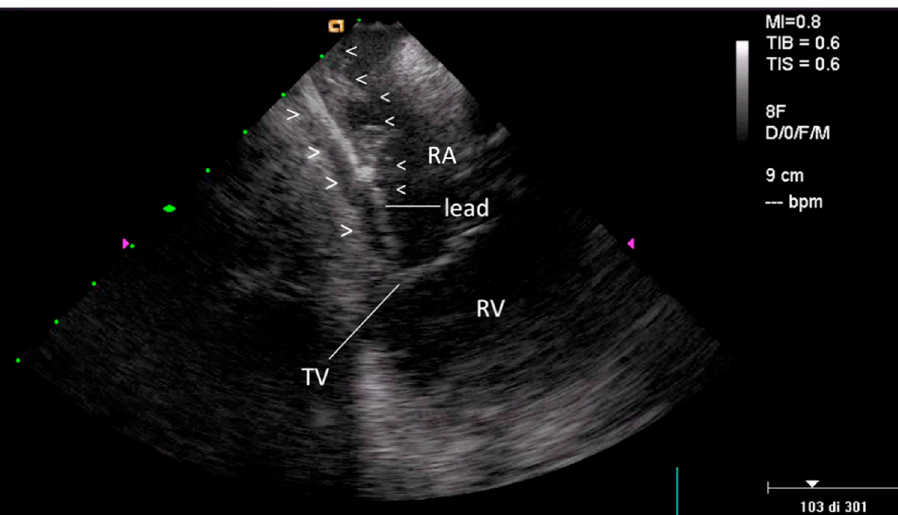
Figure 3. Fibrotic attachment to the cardiac wall (FAC) involving the atrial portion of a ventricular lead. Home view: FAC is visible as dense echoes encasing the atrial portion of a ventricular lead (arrow-heads), fixed to the atrial endocardium with loss of independent lead motion (such findings are better seen in the movie). FAC = lead fibrotic attachment to the cardiac wall; RA—right atrium; RV—right ventricle; TV—tricuspid valve.